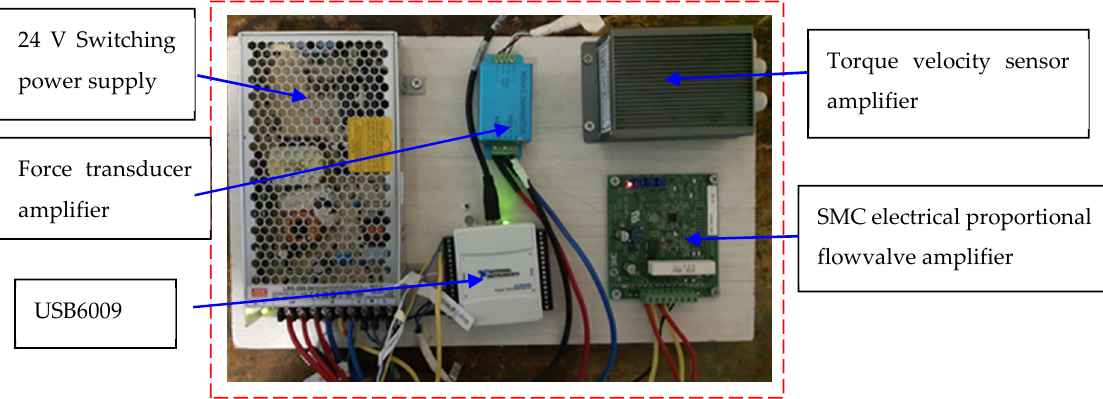
Figure 5. A structural diagram of the unconfined compressive-strength detector test system for roadway rock.